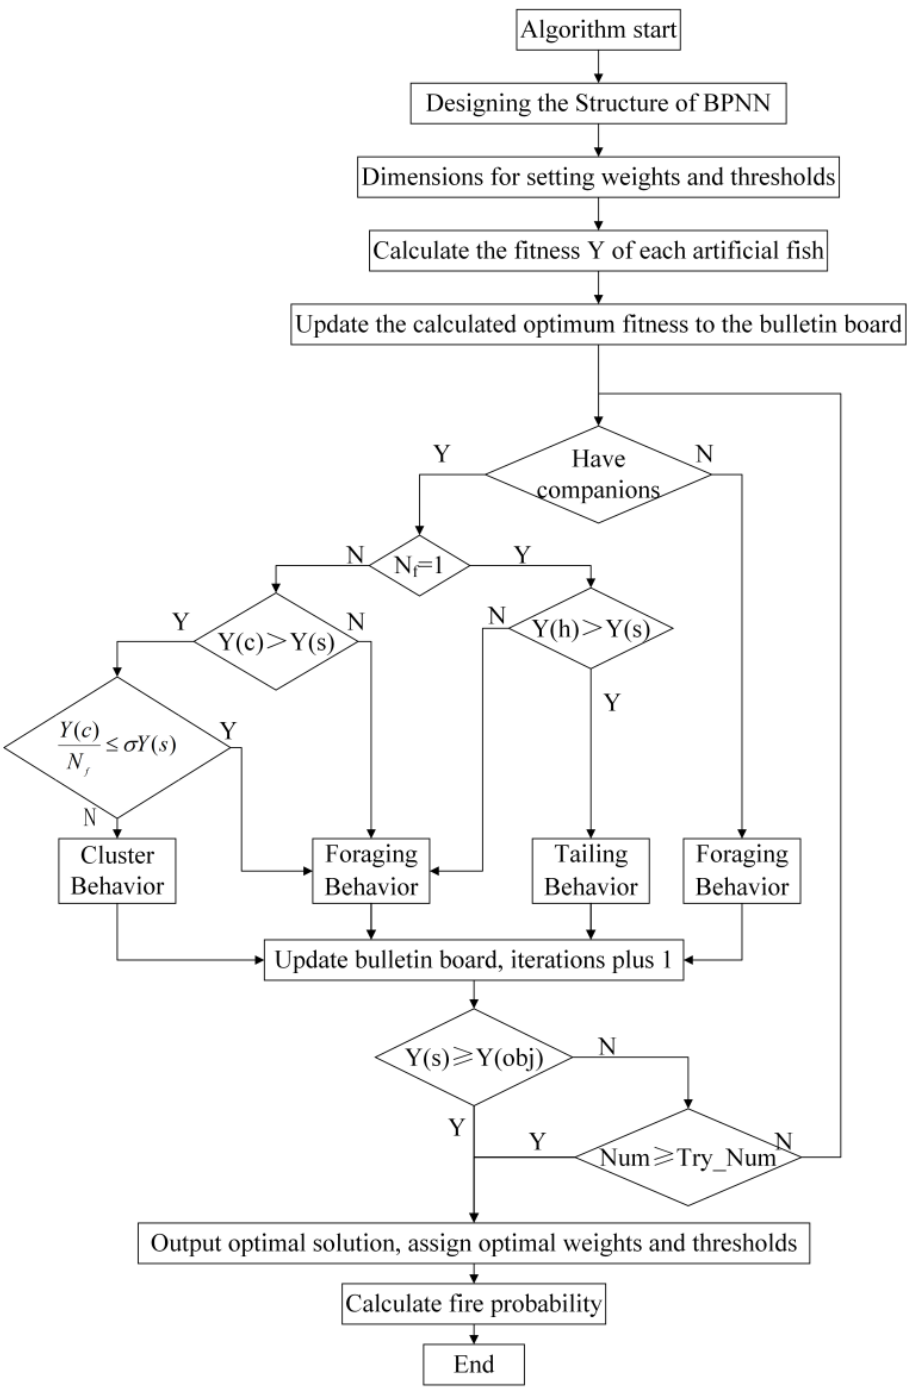
Figure 3. AFSA for optimizing flow chart of BPNN.